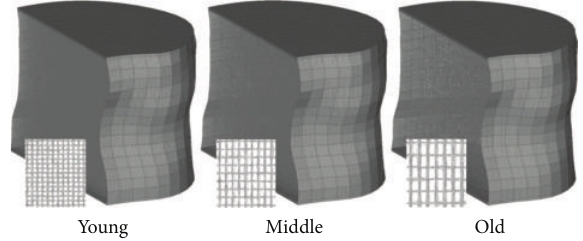
Figure 2: Vertebral body models in the three age groups—young ( < 50 years); middle (50 through 75 years); and old ( > 75 years).